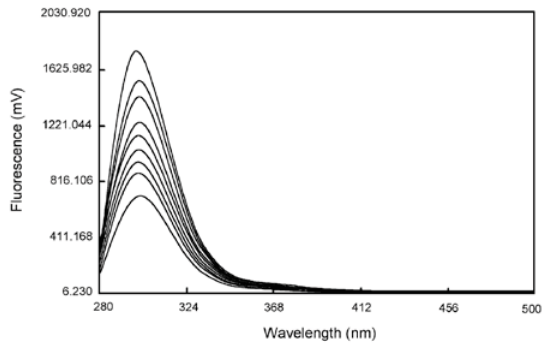
Figure 1. Photodegradation of phenol on ZnO. The fluorescence spectra of illuminated phenol diluted 200-fold stepwise and recorded at 0, 15, 30, 45, 60, 75, 90, 105, 120 min ( ↓ ). [Phenol] loading = 0.10 g, λ = 365 nm, I = 25.4 μeinstein L -1 s -1 , airflow rate = 7.8 mL s -1 , [O ] = 12.6 mg L -1 , phenol solution = 25 mL. 2 dissolved